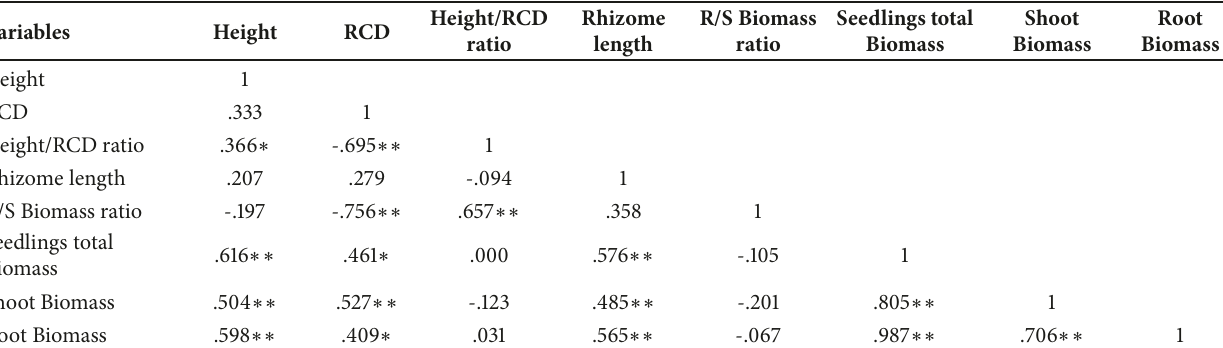
Table6:Correlationmatrixof O.abyssinica seedlingsgrowthandBiomassvariablesforSherkoleprovenance(Pearsoncoefficients,two-tailed, and n =